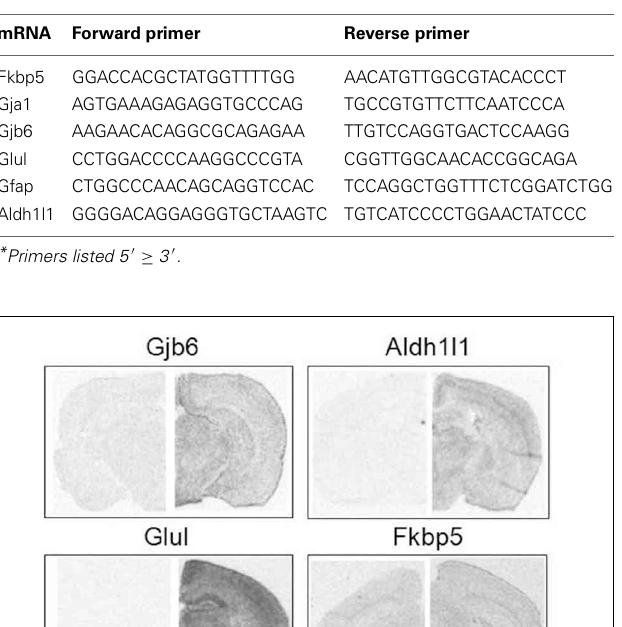
Table 2 | Primers for in situ hybridization probes.